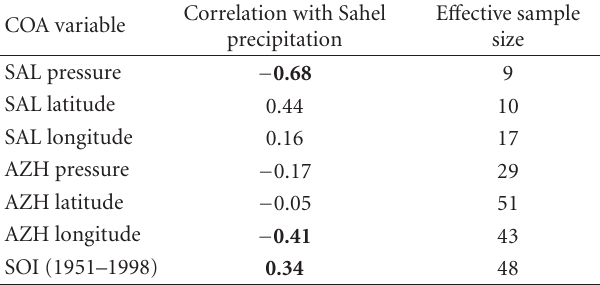
Table 1: COA variable, corresponding correlation coe ffi cient with Sahel precipitation, and e ff ective sample size. Bold: value statistically significant at the 5% level. The Azores High and South Asia data are for 1948–1998, and the SOI values are for 1951–1998.